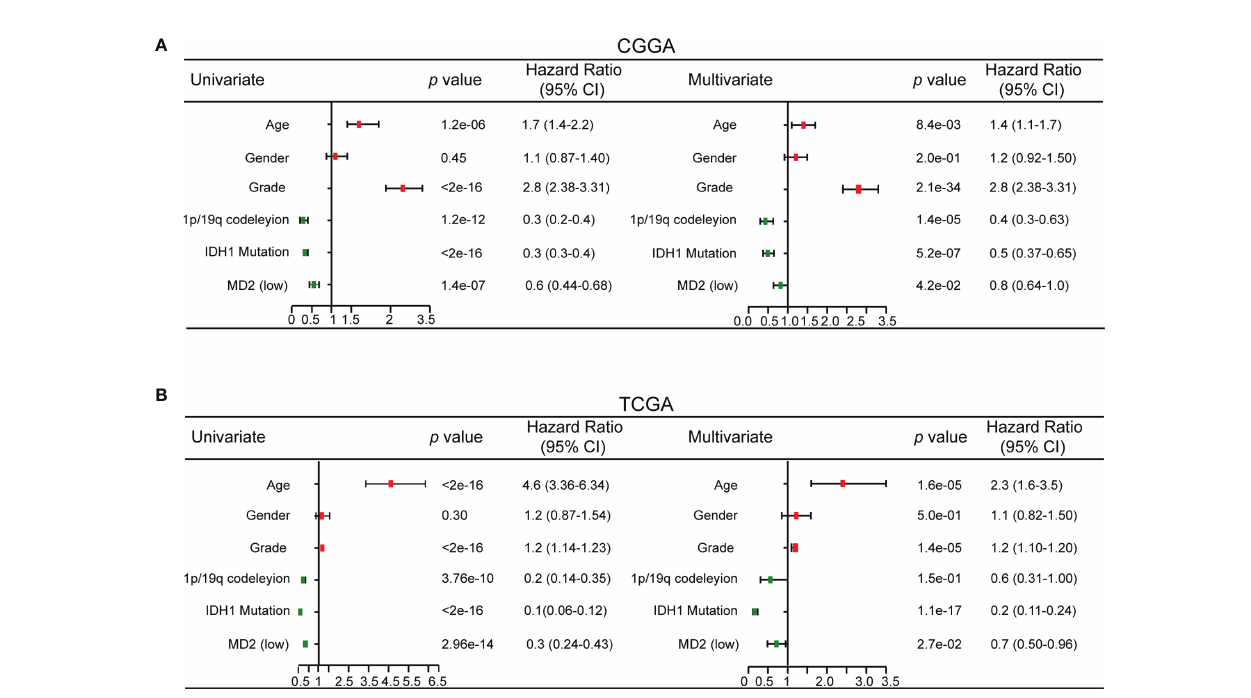
FIGURE 4 | Univariate and multivariate Cox regression analysis. (A) Univariate and multivariate Cox regression analyses risk score of MD2 expression level and several related clinical variables in CGGA database. Red color indicates disadvantageous factors, HR>1, Green color indicates protective factors, HR < 1. (B) Univariate and multivariate Cox regression analyses risk score of MD2 expression level and several related clinical variables in TCGA database. Red color indicates disadvantageous factors, HR>1, green color indicates protective factors,